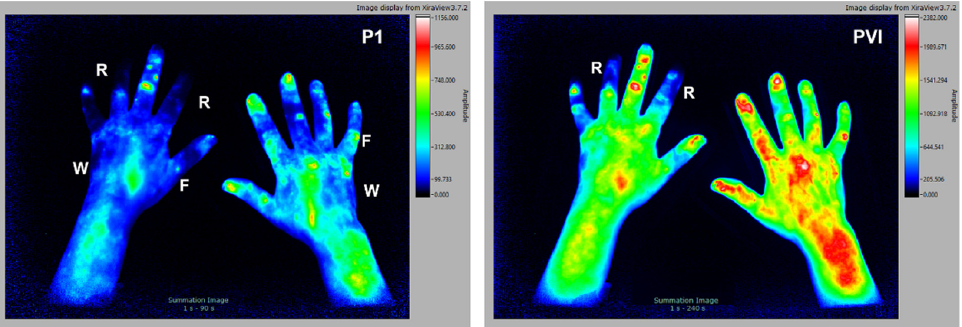
Figure 5. The 58 y/o female patient with clinical diagnosis of CREST. Signal alteration include Raynaud’s phenomenon (R), delayed inflow in all fingertips of both hands (r), punctual (F), and cloudy (W) signals in P1.